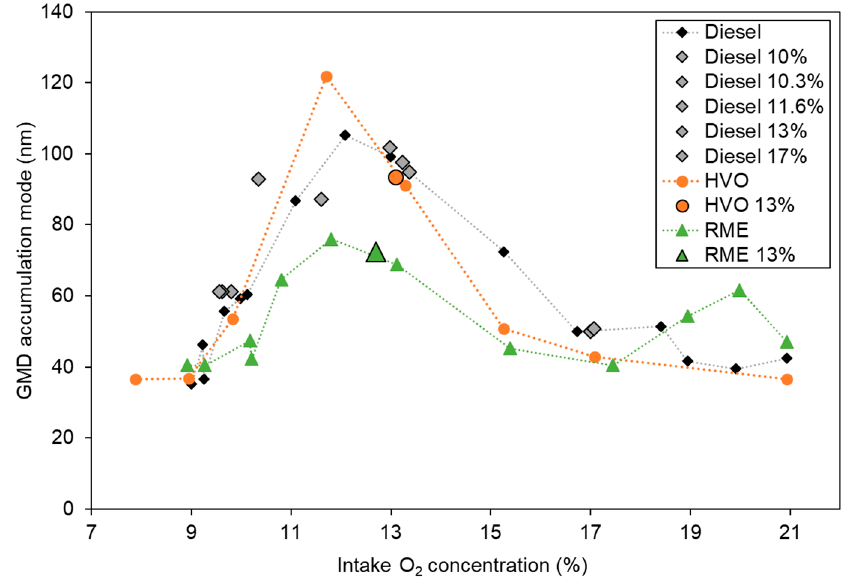
Figure A4. The accumulation mode GMD (nm) for the fuels depending on EGR (expressed as intake O 2 concentration).